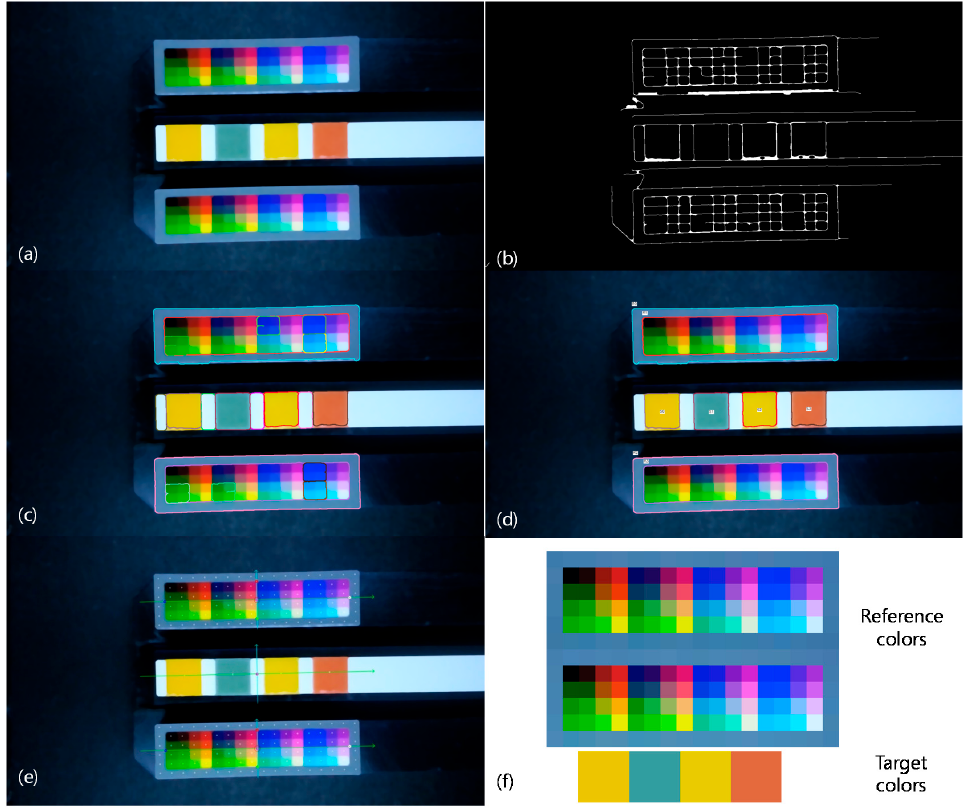
Figure 4. Automatic color retrieving algorithm: ( a ) Noise reduction and image simplification; ( b ) Edge detection; ( c ) Initial contour extraction; ( d ) Final contour labeling; ( e ) Automatic position determination to obtain reference colors and target colors; ( f ) Retrieved reference colors and target colors.